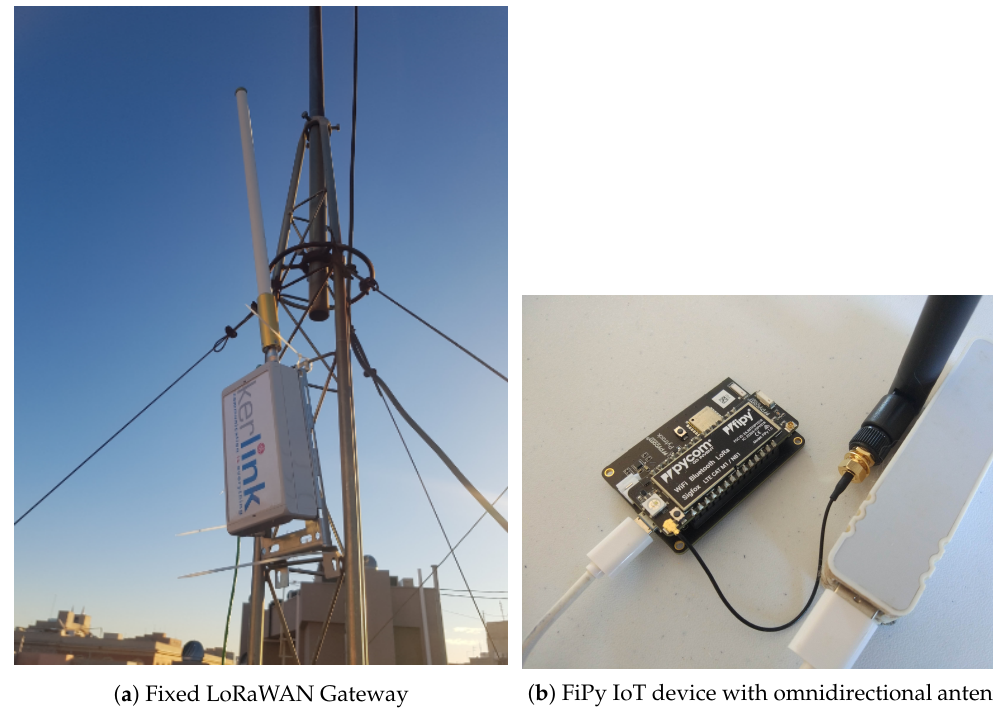
Figure 4. IoT and fixed LoRaWAN gateway used in testbeds.